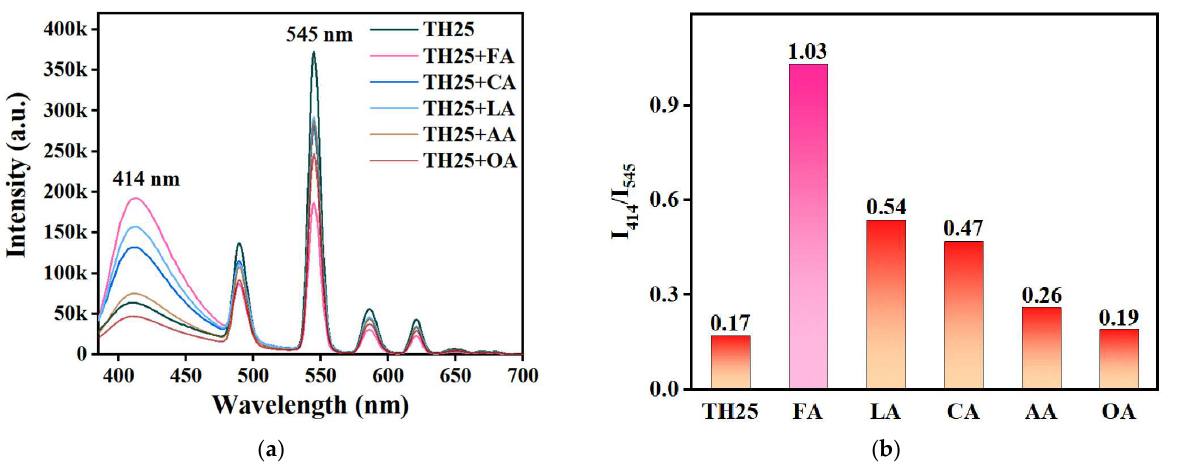
Figure 4. ( a ) Fluorescence spectra of TH25 with the addition of different organic acids ( λ ex = 365 nm); ( b ) Fluorescence ratio of emission intensity at 414 nm and 545 nm in TH25 upon addition of different organic acids.